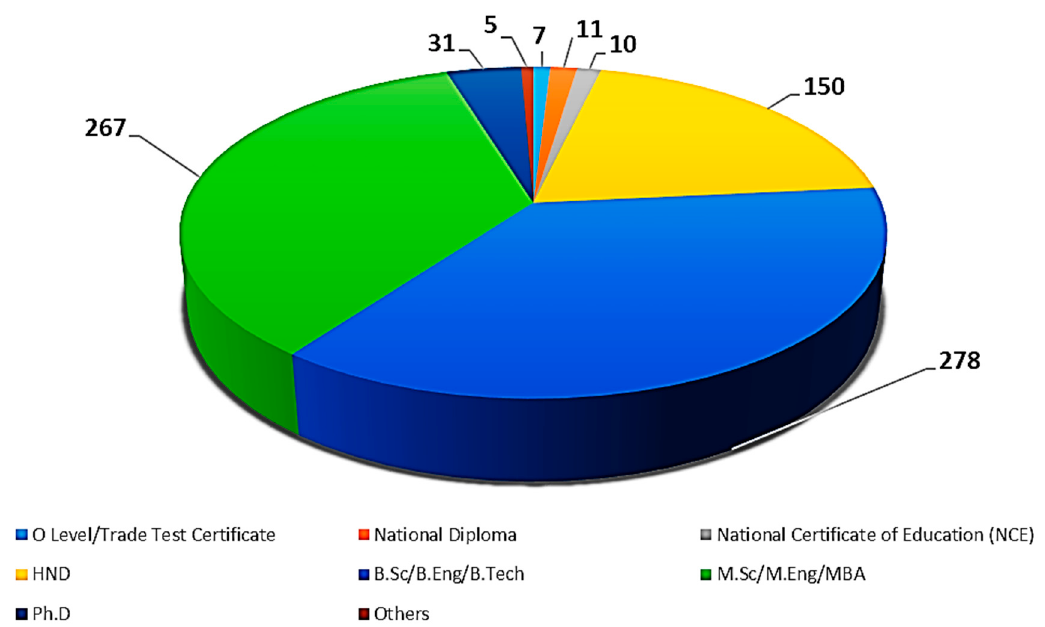
Figure 2. Highest academic qualification of construction stakeholders.